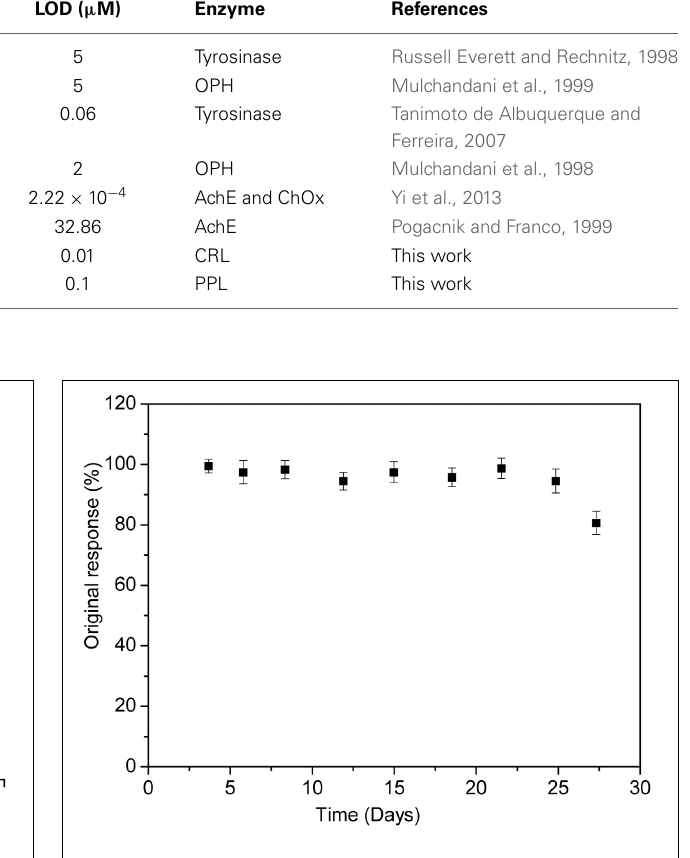
μ M diazinon in phosphate buffer, pH